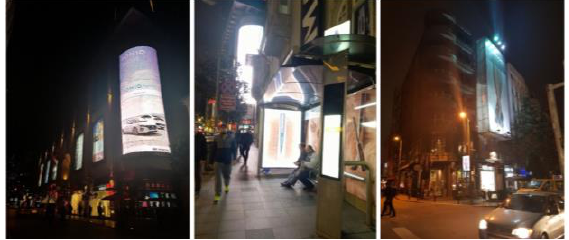
Figure 11. Advertisement Lightings Figure Lightings (photo by